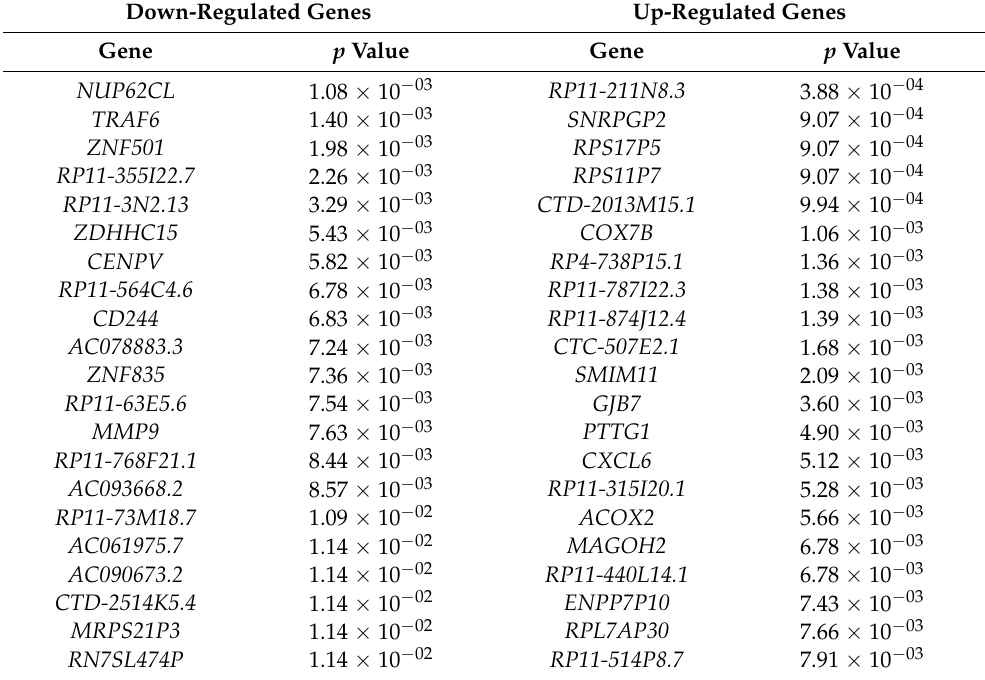
Table 3. List of top